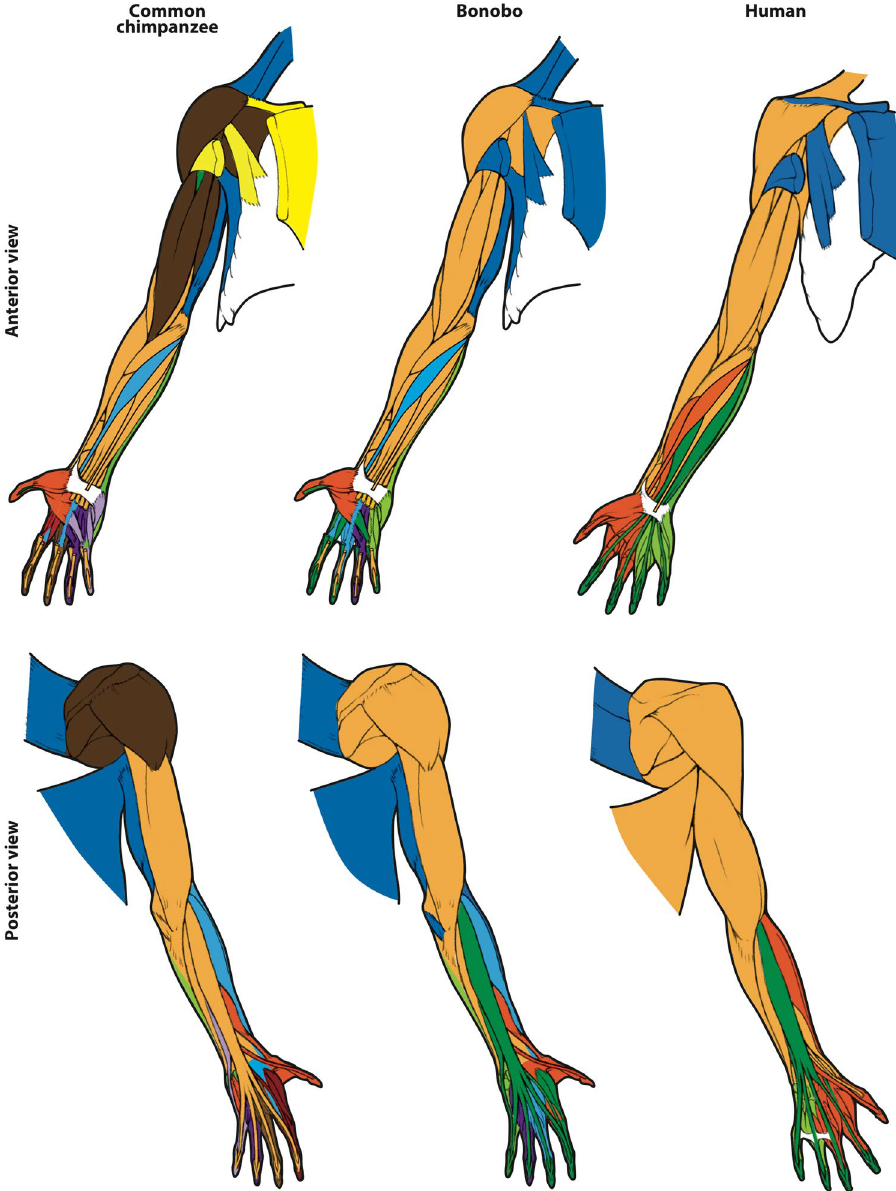
Figure 1. Forelimb anatomical network modules of common chimpanzees, bonobos and humans. While in humans there are only two modules related to the movements of the digits (dark orange: of digits 1–3, light green: of digits 4–5), in chimpanzees there are many more: four (dark orange: of thumb; light blue: of digits 2–3; magenta: of digit 4; light green: of digit 5) in bonobos, and six (dark orange: of thumb; red: of digit 2; brown: of digit 3; dark magenta: of digit 4; light green and dark blue: of digit 5) in common chimpanzees. For more details and for names and specific composition of each module, see text and SI1; for a list of all musculoskeletal structures and their connections, see